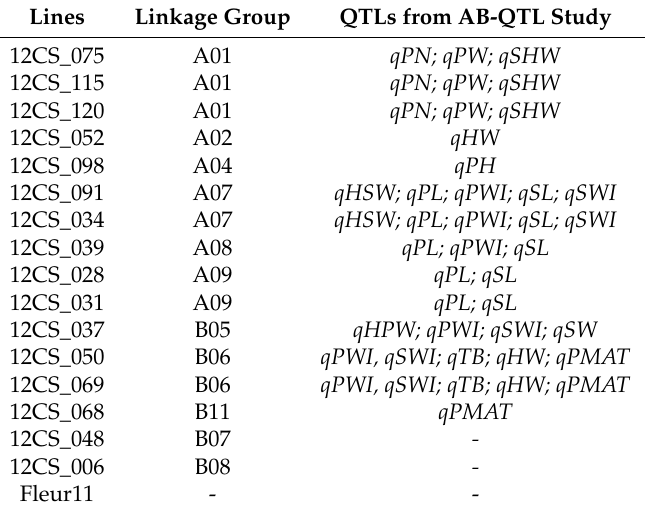
Table 1. Selected chromosome segment substitution lines (CSSLs) with corresponding quantitative trait locus (QTL) regions in the advanced backcross quantitative loci (AB-QTL) study.